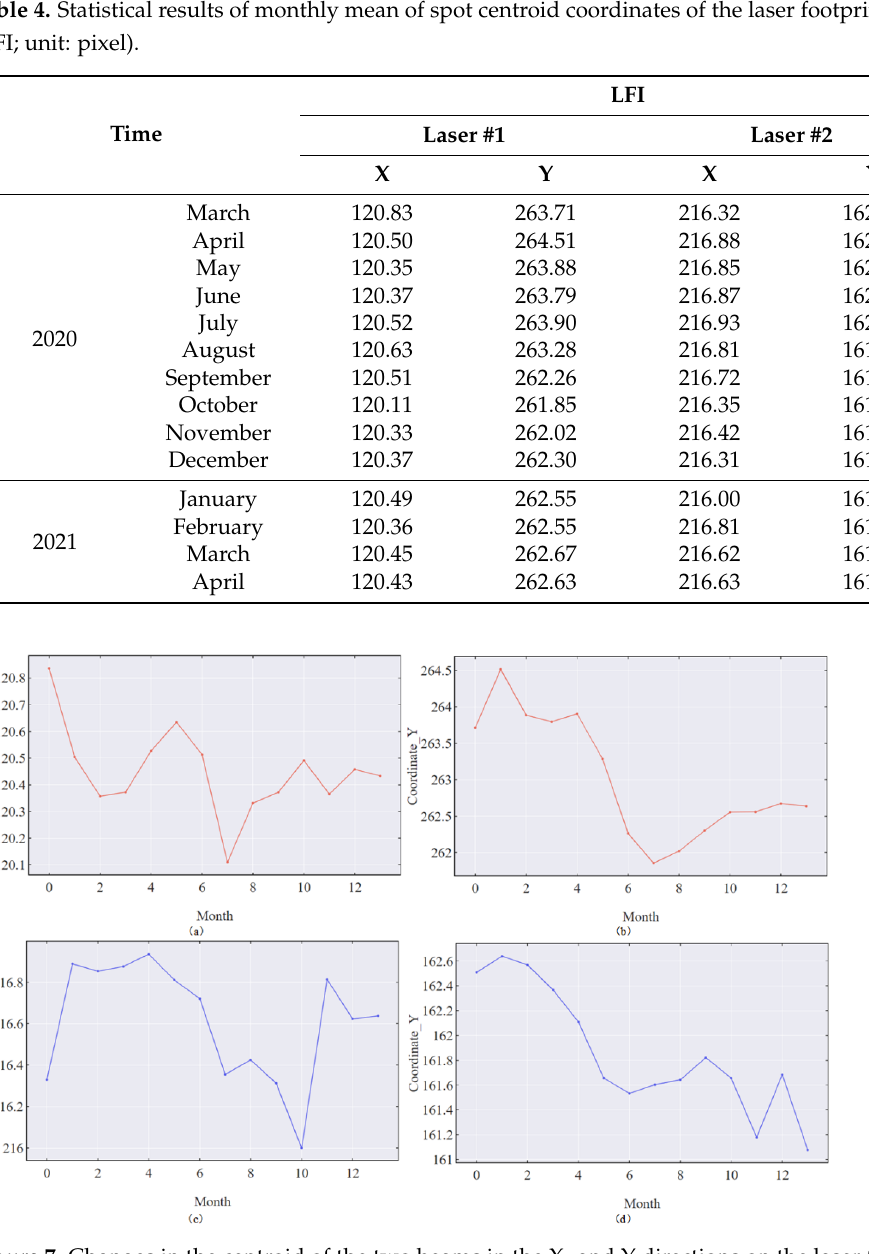
Figure 7. Changes in the centroid of the two beams in the X- and Y-directions on the laser footprint image (LFI). ( a ) and ( b ) respectively correspond to the monthly changes of the coordinates of the centroid of the laser spot of laser1 in the X and Y directions. ( c ) and ( d ) respectively correspond to the monthly changes of the coordinates of the centroid of the laser spot of laser2 in the X and Y